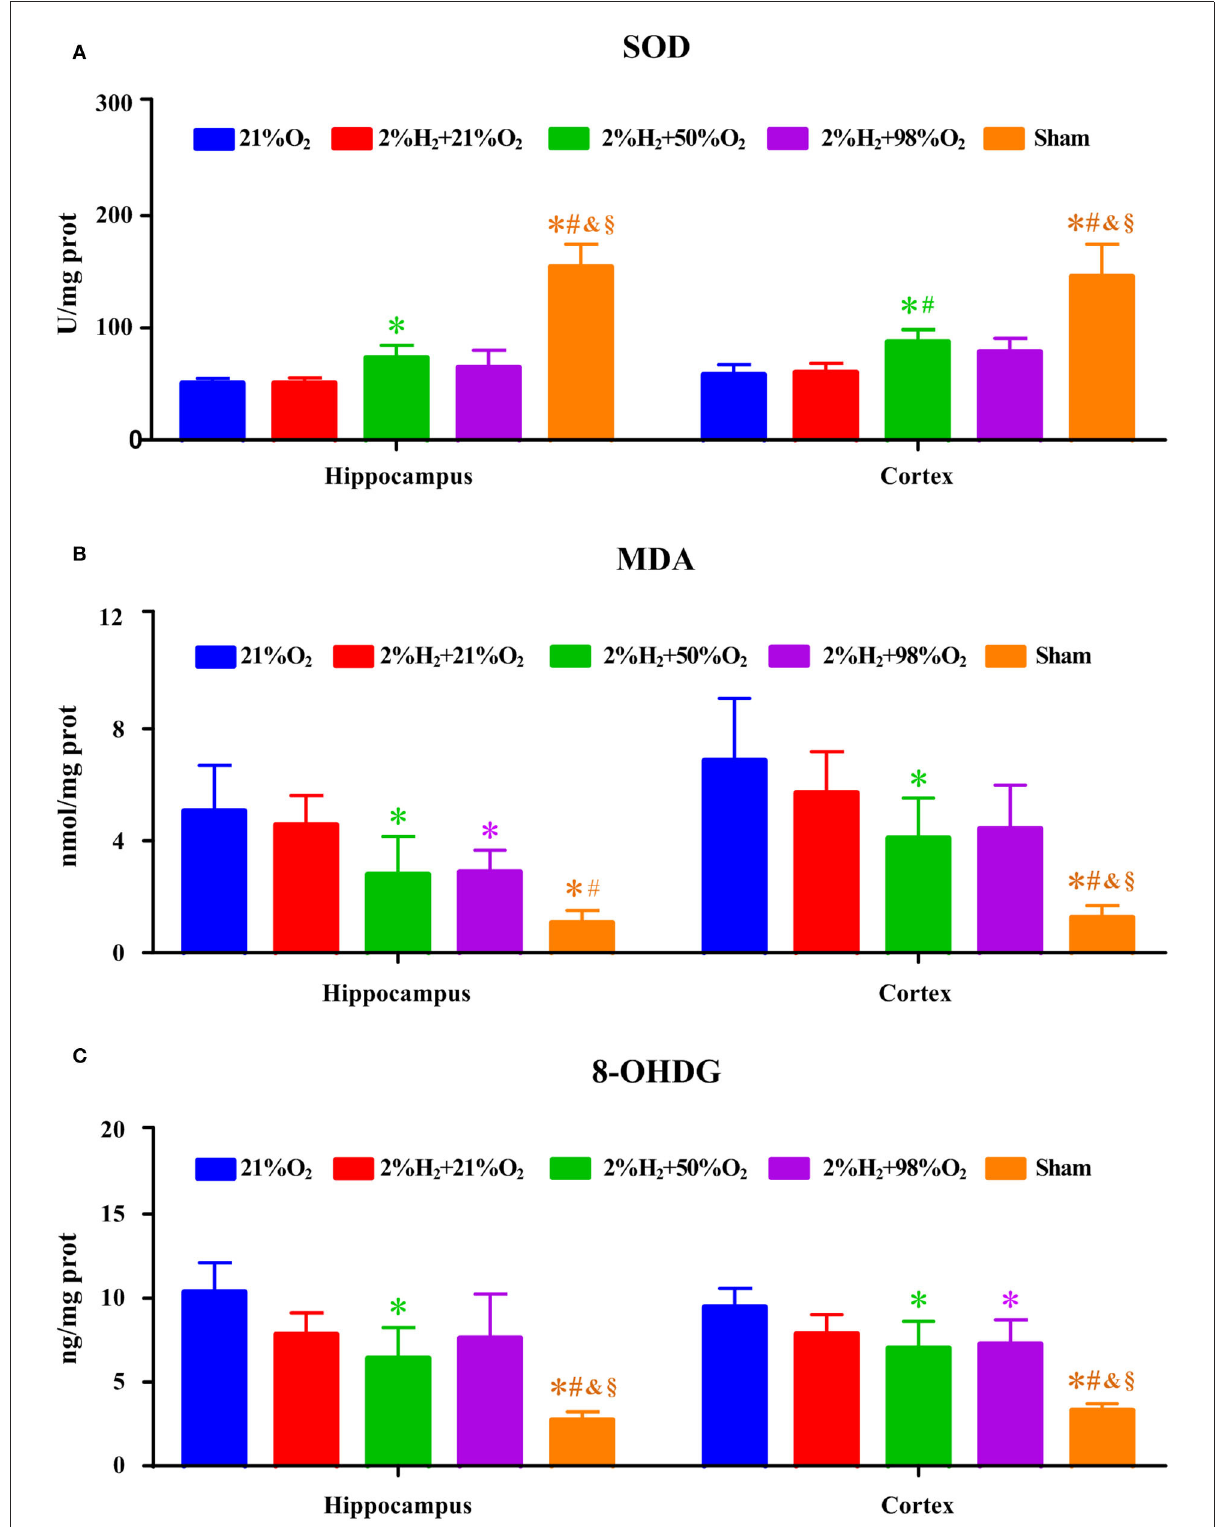
FIGURE6 The concentrations of (A) superoxide dismutase (SOD), (B) malondialdehyde (MDA), and (C) 8-hydroxy-2-deoxy guanosine (8-OHDG) of the hippocampus and were cortex measured 6h after resuscitation in animals under hypothermia. * p < 0.05 vs. 21%O 2 group; # p < 0.05 vs. 2%H 2 + 21%O 2 group; & p < 0.05 vs. 2%H 2 + 50%O 2 group; § p < 0.05 vs. 2%H 2 + 98%O 2 group. n = 5 for each